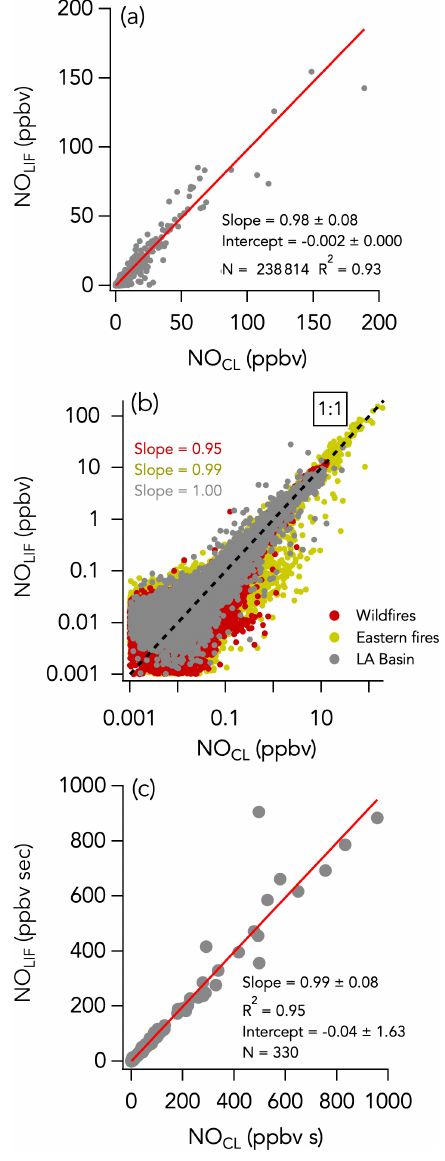
Figure 2. NO measurements by LIF vs. CL with (a) all 1s data on a linear scale, (b) all 1s data on a log scale, and (c) integrals of 330 crosswind smoke plume transects. N is the number of indepen- dent 1s observations or smoke plume transects that are compared. In panel (b) , the three sampling periods are shown in different col- ors, with the wildfires sampling period in red, the eastern fires sam- pling period in mustard, and the Los Angeles (LA) Basin flights in grey. The red lines indicate the fit of the data. The dotted black line is the 1:1